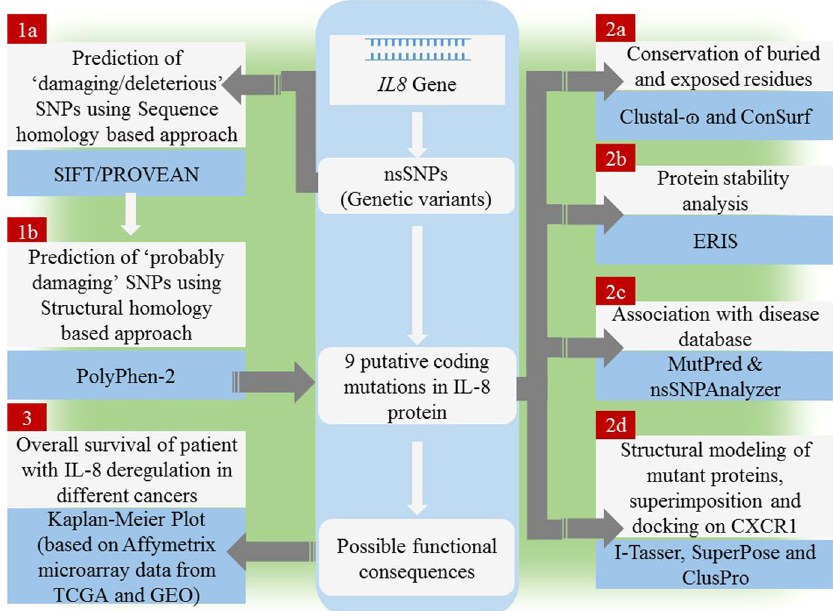
Figure 2. An overview of the experimental design for in-silico identification/characterization (step 1), validation (step 2) of nsSNPs in IL8 gene and associating deregulation of IL8 gene with survival of cancer patients (step